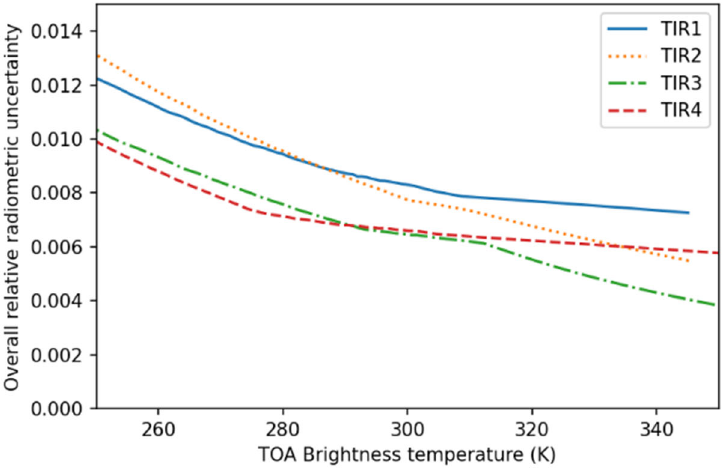
Figure 3. Overall radiometric accuracy of a given pixel over representative scenes, expressed in relative to the TOA radiation for each TRISHNA band.